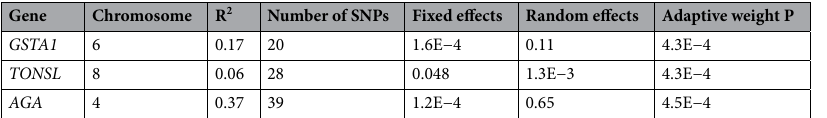
Table 2. Top genes from MiSTi for gene-based interactions with total folate for colorectal cancer based on Adaptive Weight Test p-values with FDR < 0.2. Models were adjusted for age, sex, study, sex-study specific quartiles of total energy consumption in kcal, and principal components to account for population stratification.